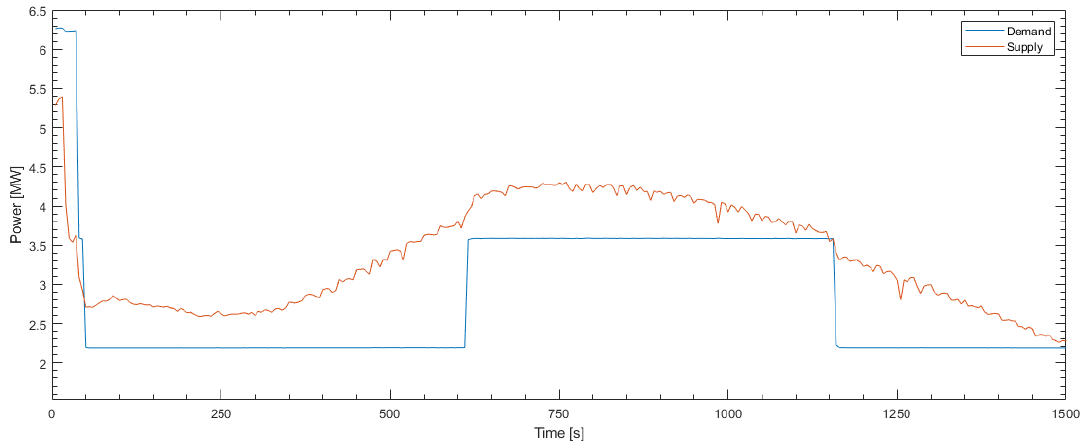
Figure 14. Multiagent System with Dispatch